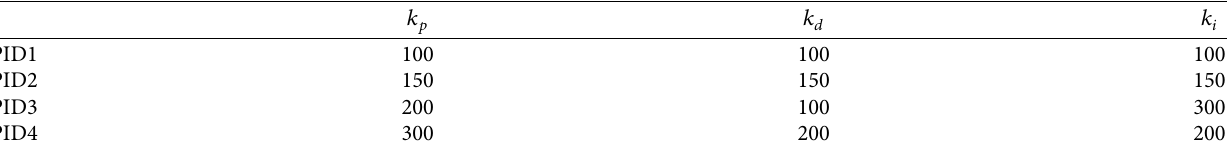
Figure 5: Simulation block diagram of depth control. Table 5: PID parameter